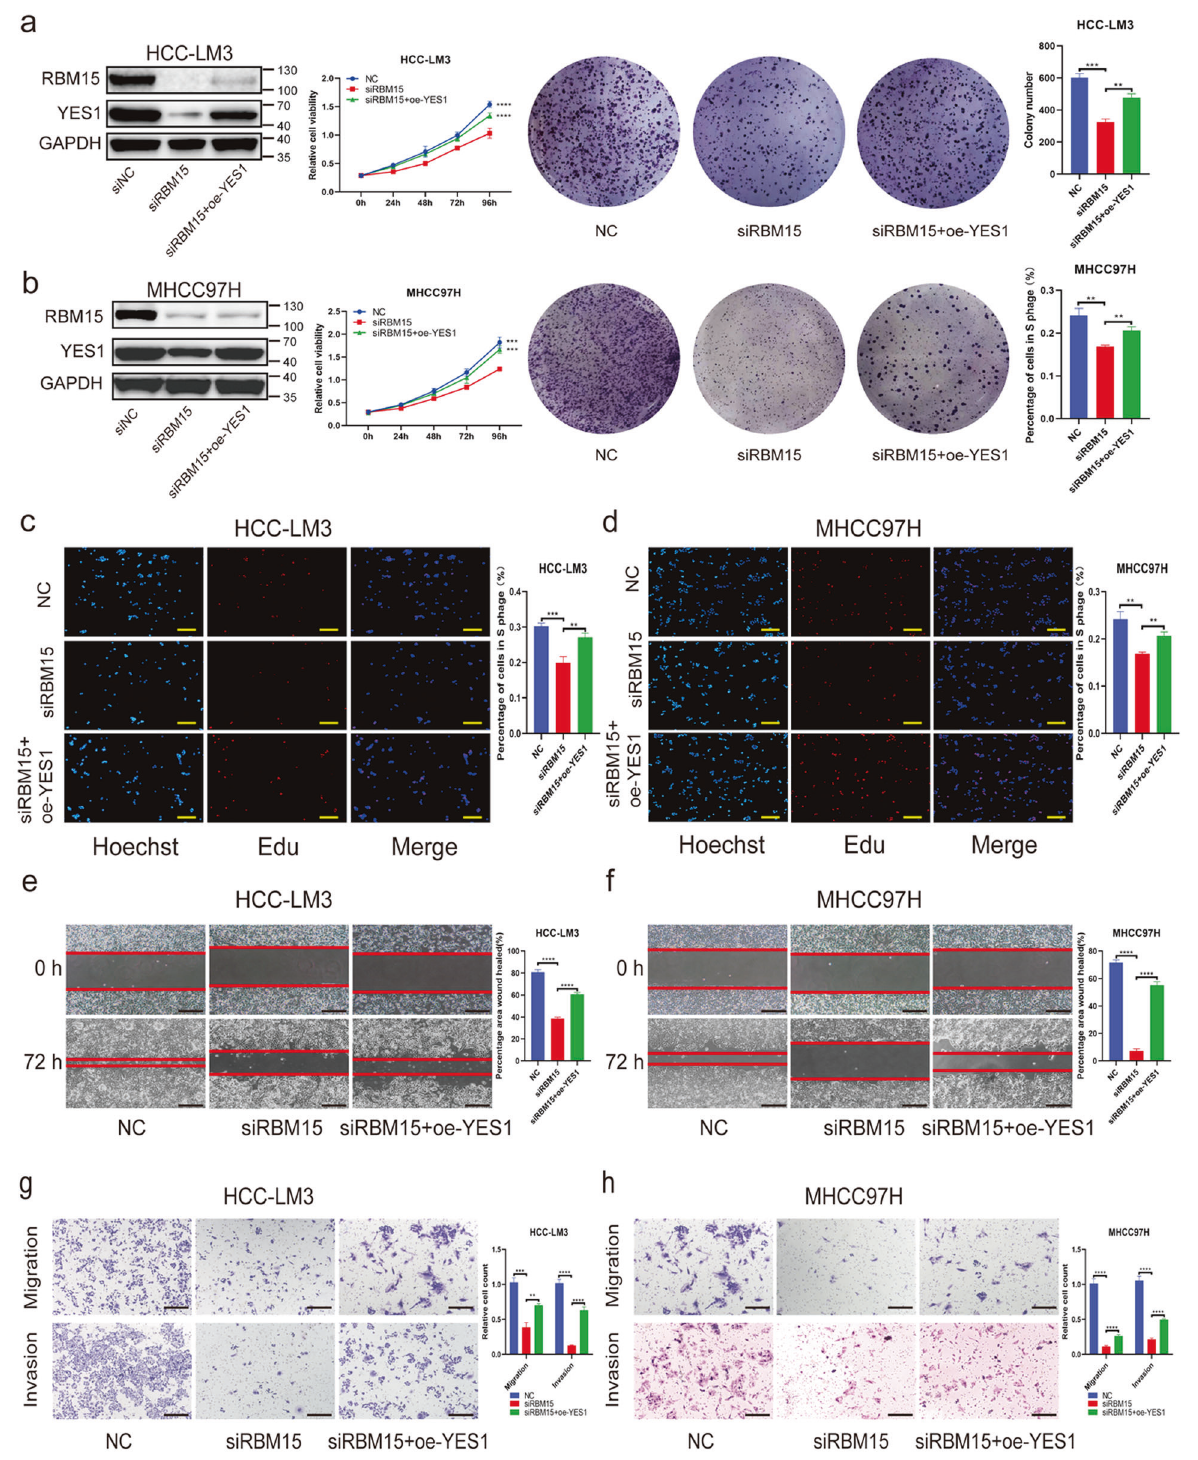
Fig. 7 Overexpression of YES1 could rescue the phenotype induced by RBM15 knockdown. a – d Rescue experiments (CCK8, colony- formation assays, and EdU assays) were performed to test the in fl uence of YES1 overexpression on growth of RBM15-knockdown HCC cells (** p < 0.01, *** p < 0.001, **** p < 0.0001; two-way ANOVA and t test); e – h rescue experiments (wound-healing assays and transwell assays) were performed to test the in fl uence of YES1 overexpression on migration/invasion ability of RBM15-knockdown HCC cells (** p < 0.01, *** p < 0.001, **** p < 0.0001; t test; scale bars, 200 μ m). The data are presented as mean ±